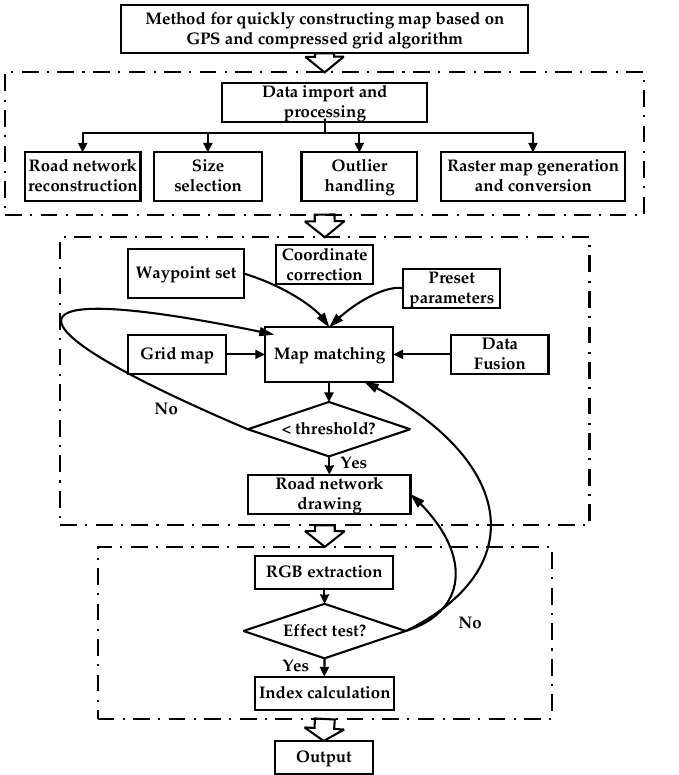
Figure 1. Flowchart of the main algorithm of the proposed method for fast map construction based